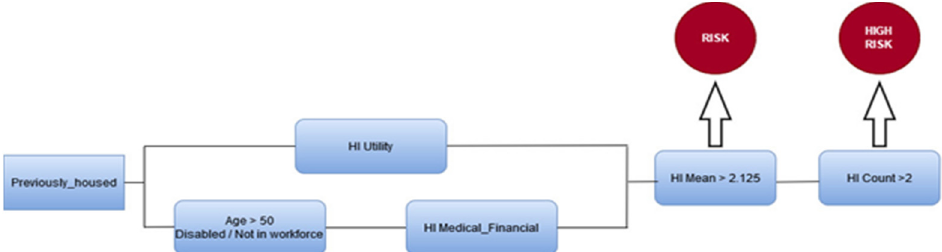
Figure 3. Co-occurring factors leading to increased risk of experiencing homelessness.